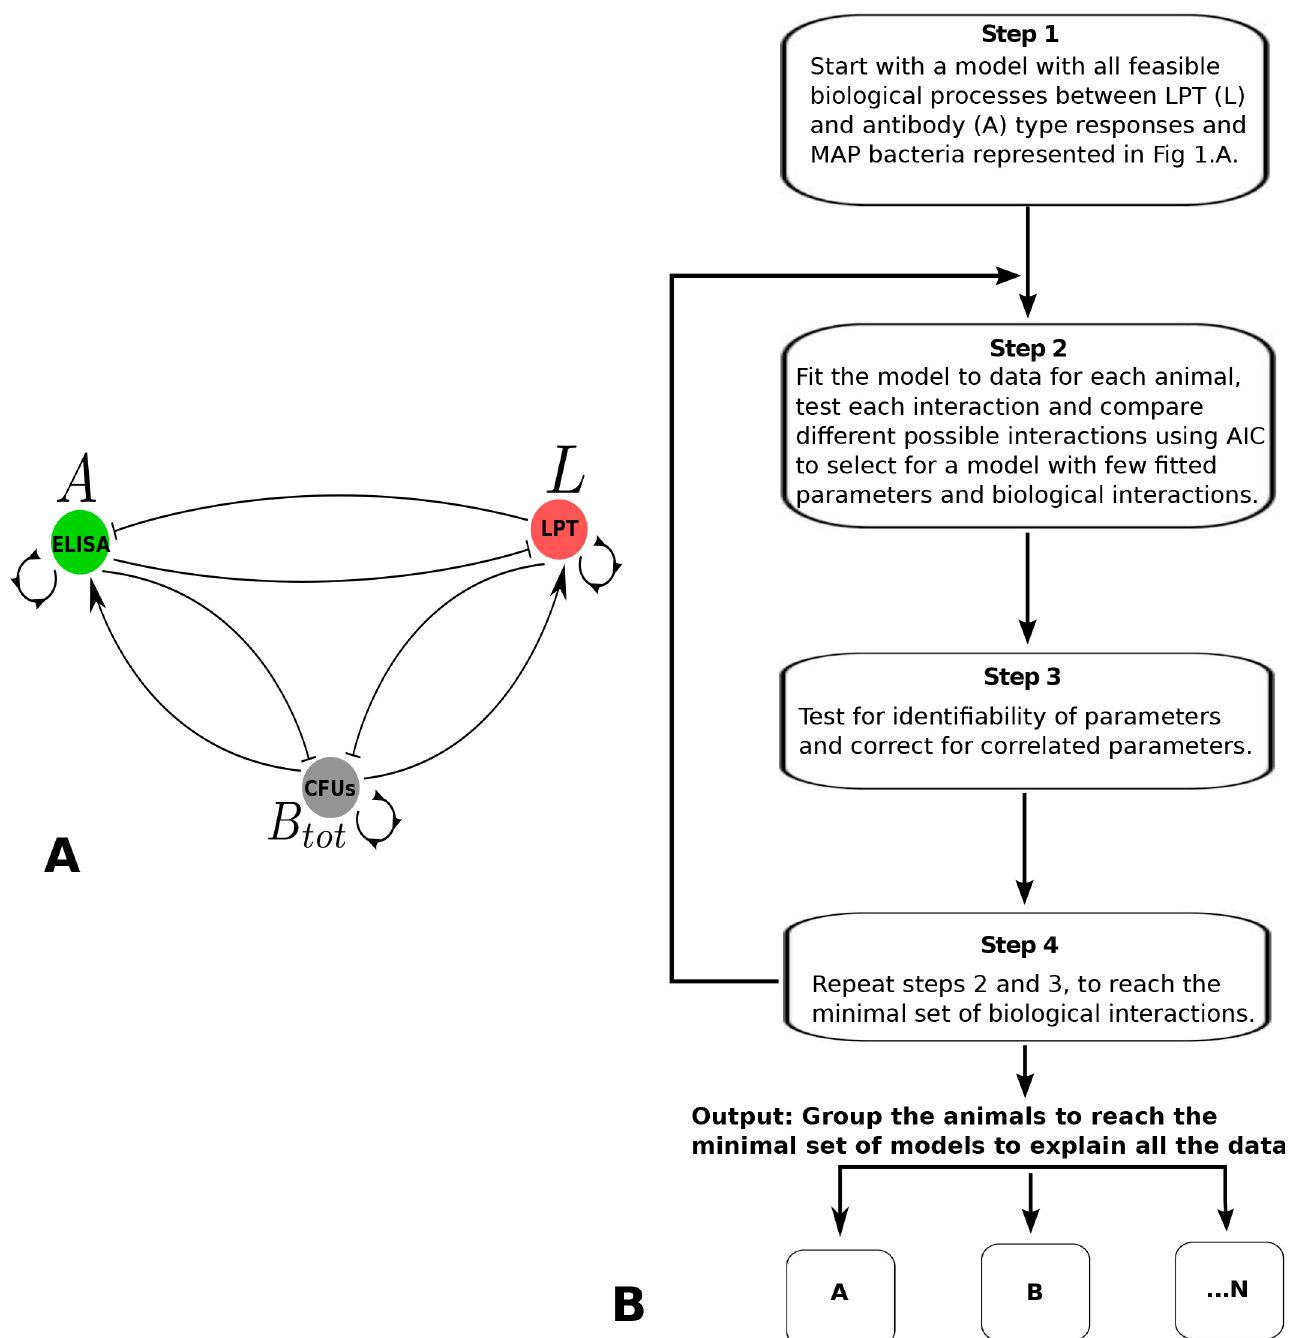
Fig 1. Model Cartoon and Model Selection Flowchart. A. Possible immune response interactions. Lymphocyte proliferative T (LPT) cell response data is used as a proxy for a CMI response ( L ), ELISA data is used as proxy for the antibody response ( A ), and CFU data is used as a proxy of within-host population MAP bacterial density ( B tot ) at the site of infection. Interactions represented here assume that CMI and the antibody/humoral response cross suppress and that free bacteria will drive development of both immune responses (CMI and AMI); the immune responses are assumed to suppress the MAP population. B. Illustration of the step-by-step model selection procedure used to refine the model with all the feasible biological interactions to derive the reduced minimal models with the essential biological interactions that can explain the data.